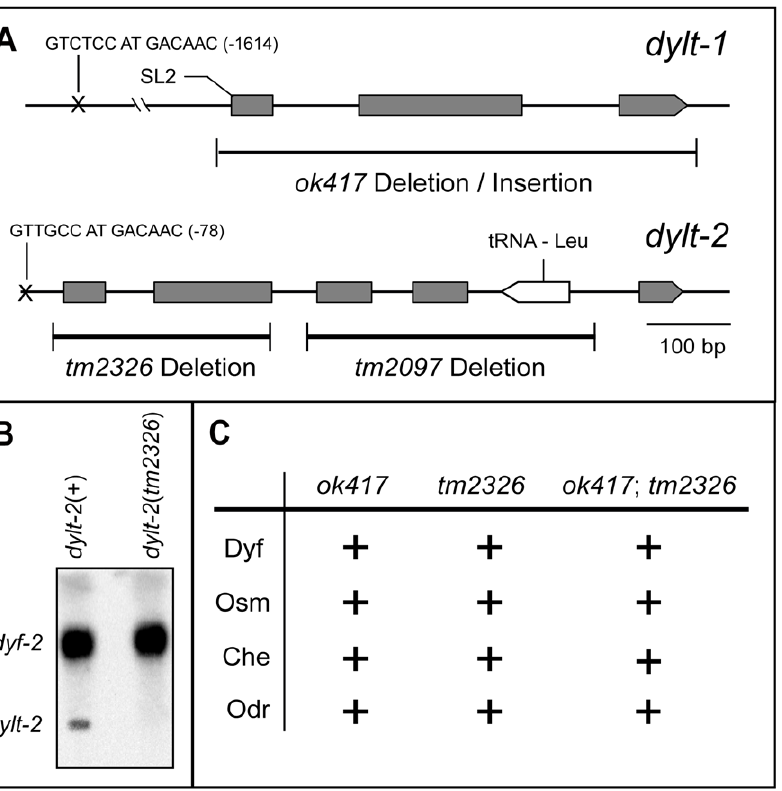
Figure 3. Functional analysis of the dylt-1 and dylt-2 genes. (A) Genomic organization of the dylt-1 and dylt-2 genes. The positions of X-box promoter motif sequences and the respective deletion mutant alleles are indicated. (B) Northern blot analysis of total RNA from dylt-2 ( + ) and dylt- 2 ( tm2326 ) mutant worms. In dylt-2 ( tm2326 ) mutants, expression of dylt-2 was abolished in comparison with wild-type worms. The blot was also probed for dyf-2 as a control. (C) Functional assays for dylt-1 and dylt-2 mutant worms. Both analyzed deletion mutants demonstrated wild-type responses ( + ) with regard to fluorescent dye filling (Dyf), avoidance of high osmotic strength (Osm), chemotaxis to sodium chloride (Che) and odorant sensation assays using Diacetyl (Odr). The same results were obtained with dylt-1(ok417);dylt-2(tm2326) double mutants.